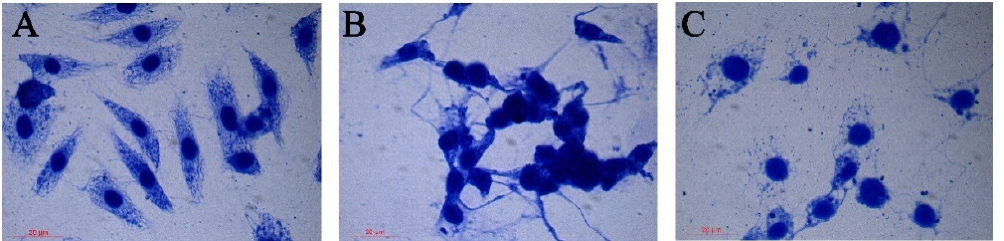
Figure 4. Differences in the skeleton of SL-1 cells after 24 h treatment with different concentrations of rotenone. Control: ( A ); 0.2 µg/mL of rotenone: ( B ); 20 µg/mL of rotenone: ( C ).